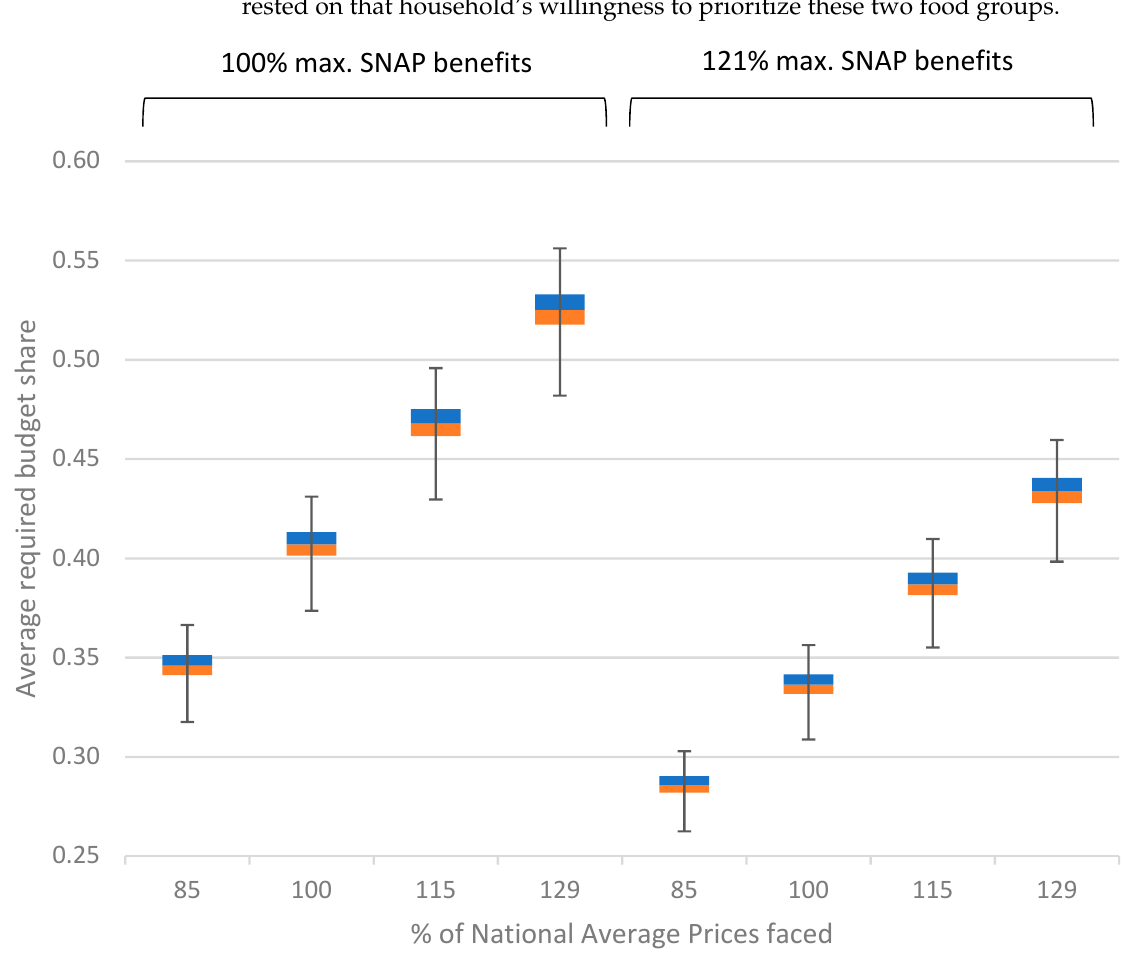
Figure 1. Results of simulation conducted to assess affordability of fruit and vegetable baskets sufficient to satisfy Federal dietary recommendations for both food groups for a 4-person family over 1 week with maximum SNAP benefits based on historic and modernized Thrifty Food Plan. Households residing in communities with below average food costs had some addi- tional flexibility even prior to the 2021 TFP modernization. Simulation results show that, if our representative 4-person households received SNAP benefits equal to the historic TFP and faced food prices 15% below national average prices, it could have afforded the baskets generated in this study with only 32% to 37% percent of its